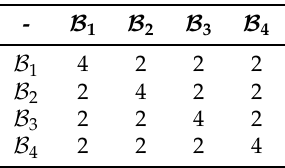
Table 2. The necessary number of crossings between two different subgraphs T i and T j for the configurations B k and B l